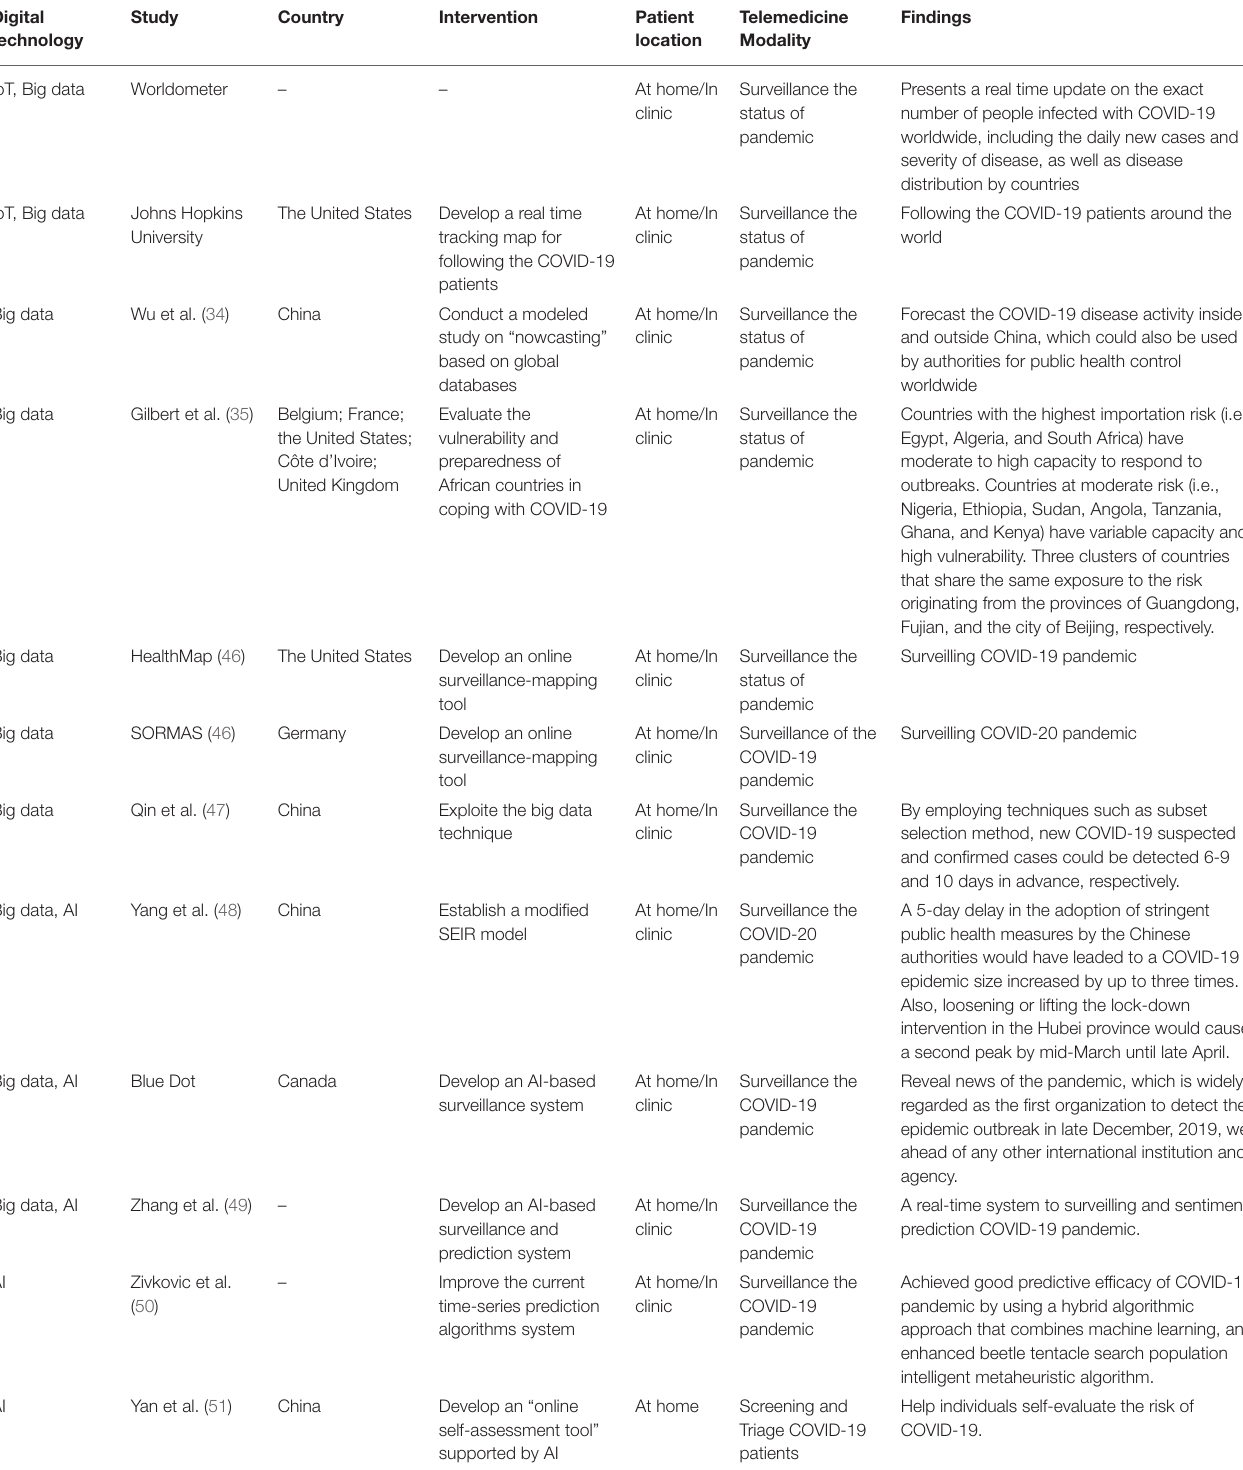
TABLE 1 | Digital technology based telemedicine and their impact on public-health strategies during the COVID-19 pandemic. Digital